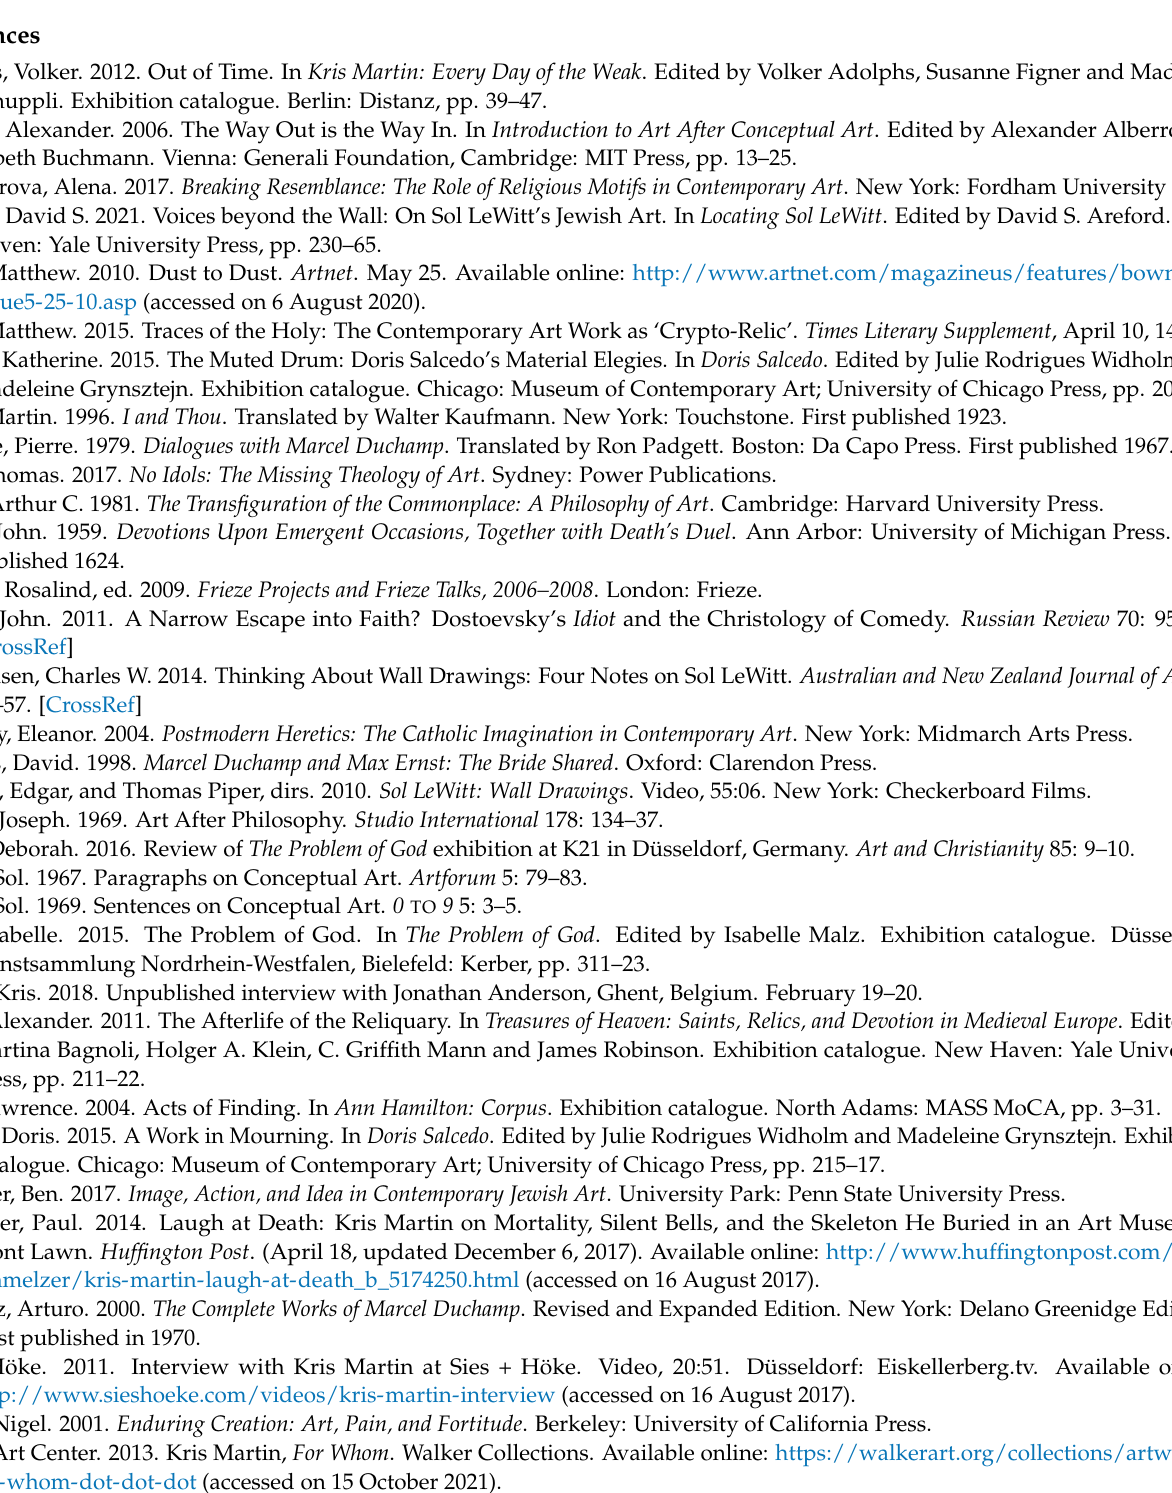
For the sake of clarity, I have altered the punctuation of this quotation, inserting parentheses around phrases that, in the original, are offset only by commas. The full original sentence is: “O eternal and most gracious God, who hast been pleased to speak to us, not only in the voice of nature, who speaks in our hearts, and of thy word, which speaks to our ears, but in the speech of speechless creatures, in Balaam’s ass, in the speech of unbelieving men, in the confession of Pilate, in the speech of the devil himself, in the recognition and attestation of thy Son, I humbly accept thy voice in the sound of this sad and funeral bell”. For the biblical references in this sentence, see Num 22:22–35 (speech of Balaam’s donkey); John 18:28–19:16 (speech of Pontius